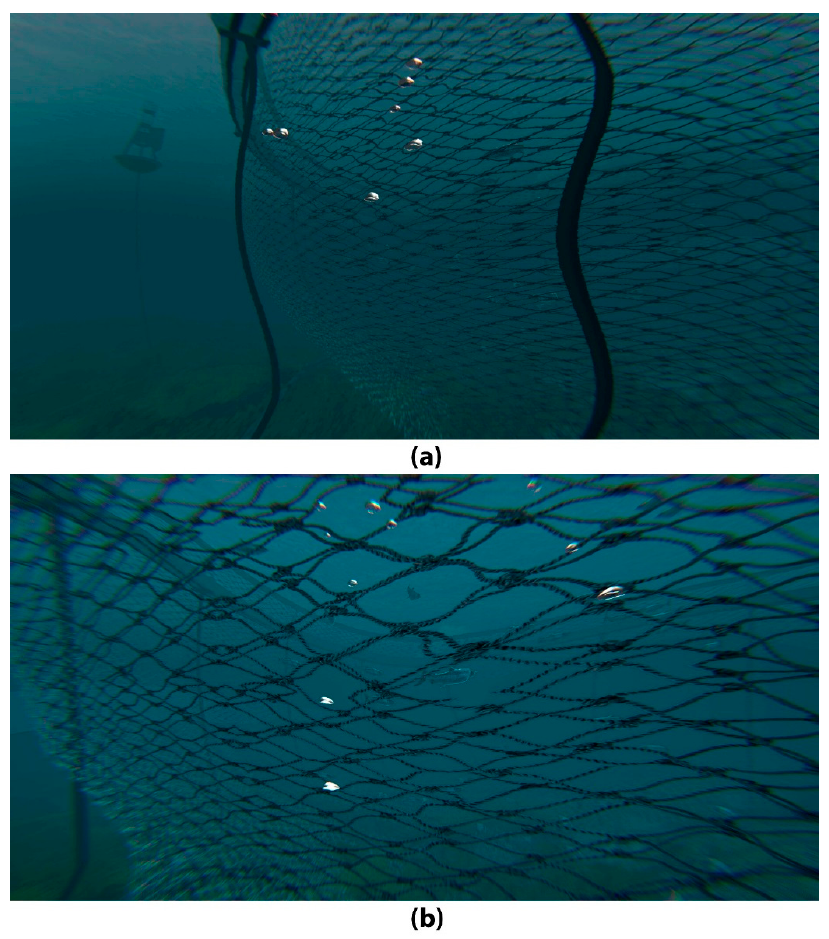
Figure 3. ( a ) Underwater view, and ( b ) close-up view of the net.